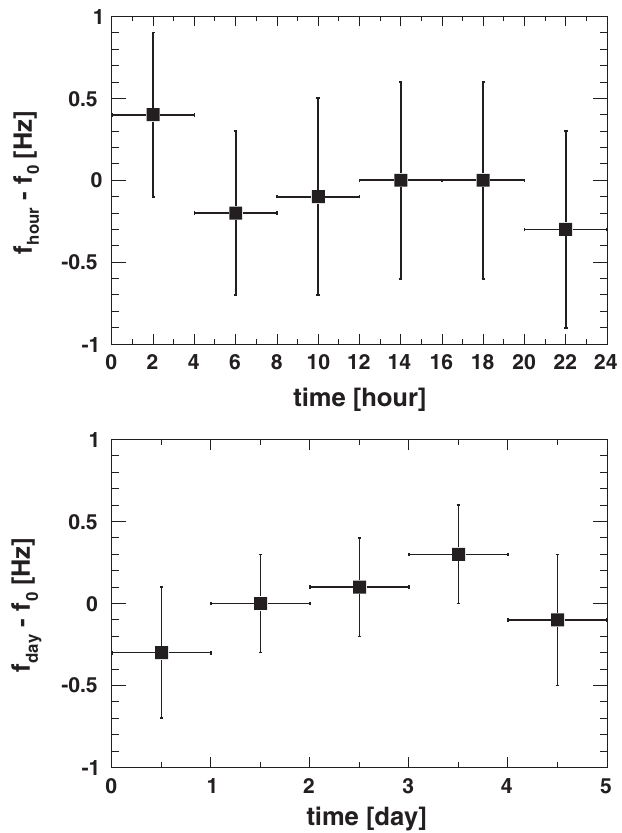
FIG. 5. Stability of the revolution frequency f 0 . In panel (a) the differences between the revolution frequencies for every four hours and the mean revolution frequency of the day are shown. In panel (b) the differences between the revolution frequencies for each day and the mean revolution frequency of the five days of Schottky data taking are shown. From these figures it is clear that the revolution frequency at COSY is very stable, with variations below 1 Hz at a circulation frequency of f 0 (cid:2) 1 : 4 MH z